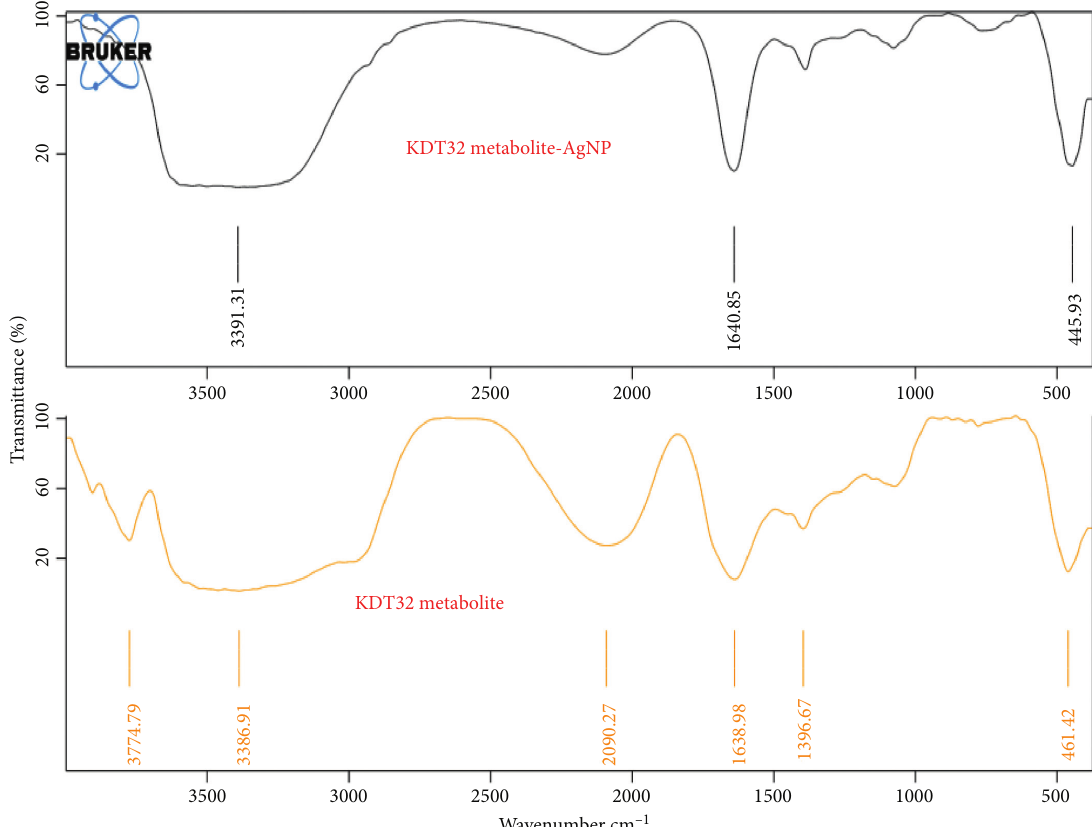
Figure 4: FTIR spectra comparison between the KDT32 metabolite and